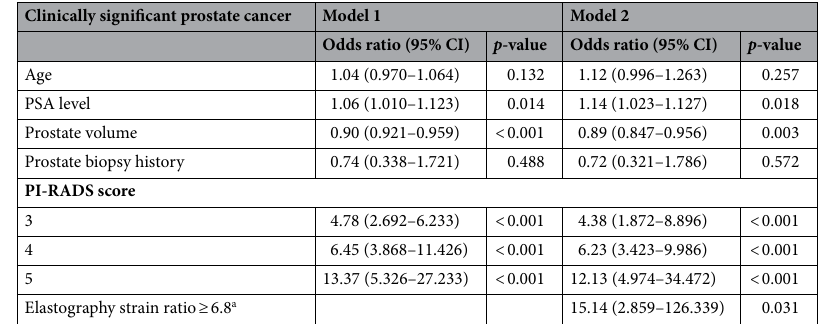
Table 3. Results of multivariable logistic regression analyses for predicting clinically significant prostate cancer on targeted biopsy. Data are presented as median (interquartile range). a Cut-off value of the strain ratio predicting clinically significant prostate cancer using the Youden index. CI, confidence interval; PI-RADS, Prostate Imaging Reporting and Data System; PSA, prostate-specific